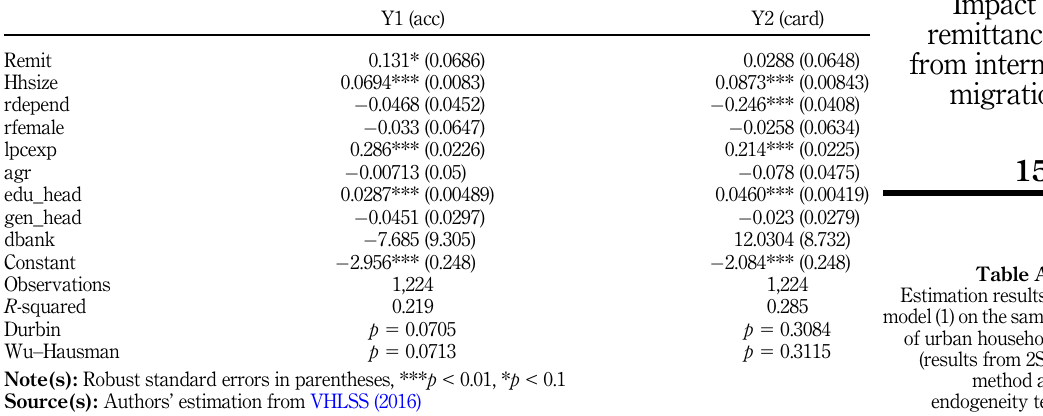
Table A3. Estimation results